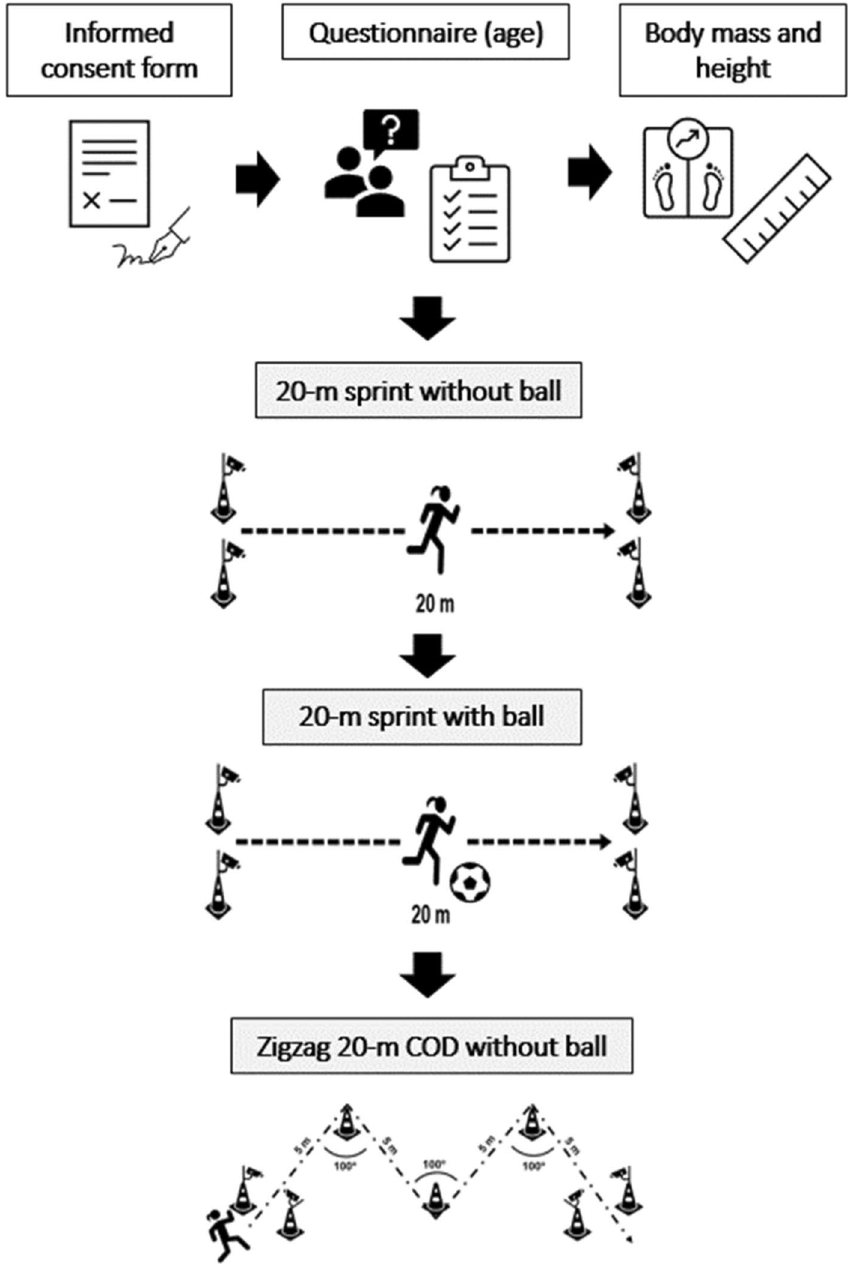
Figure 1. Data collection procedures. COD